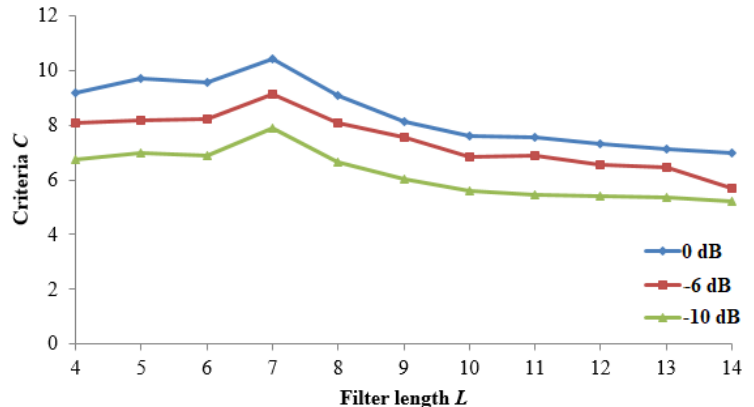
Fig. 4. The dependency C ( L ) for the algorithm based on quadratic